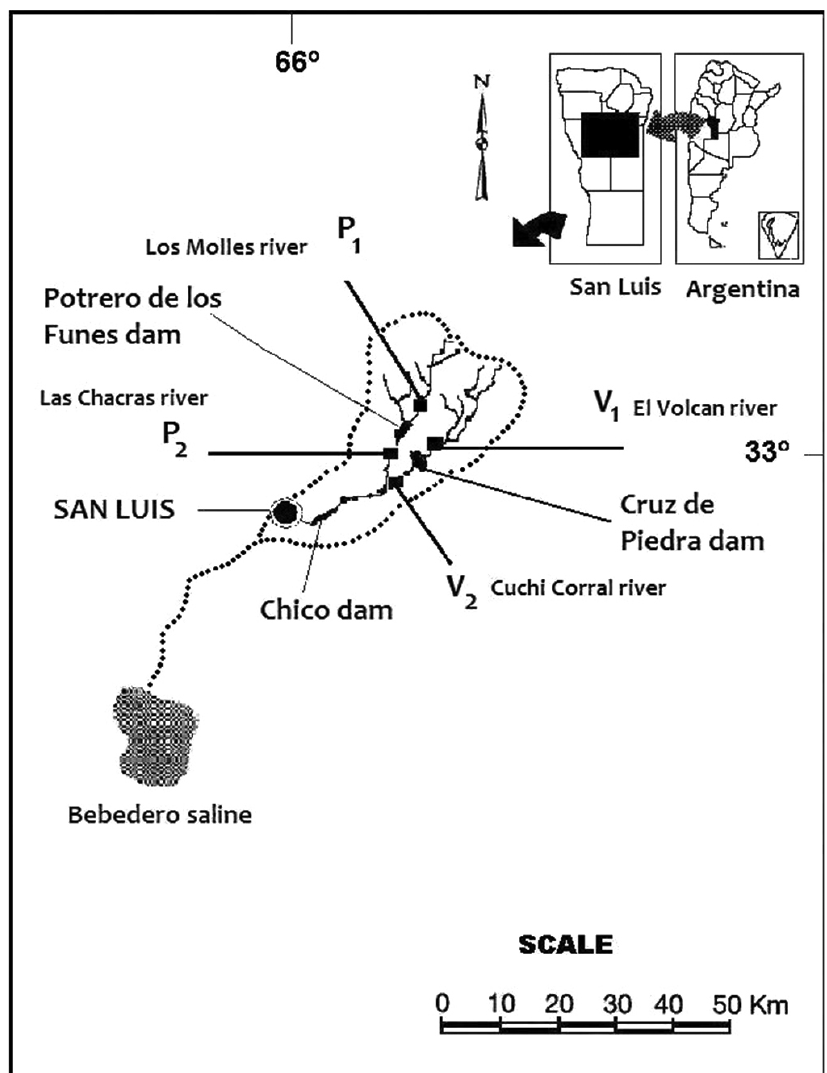
Figure 1. Location of the sampling sites in the Bebedero Basin: V Mollles River and P